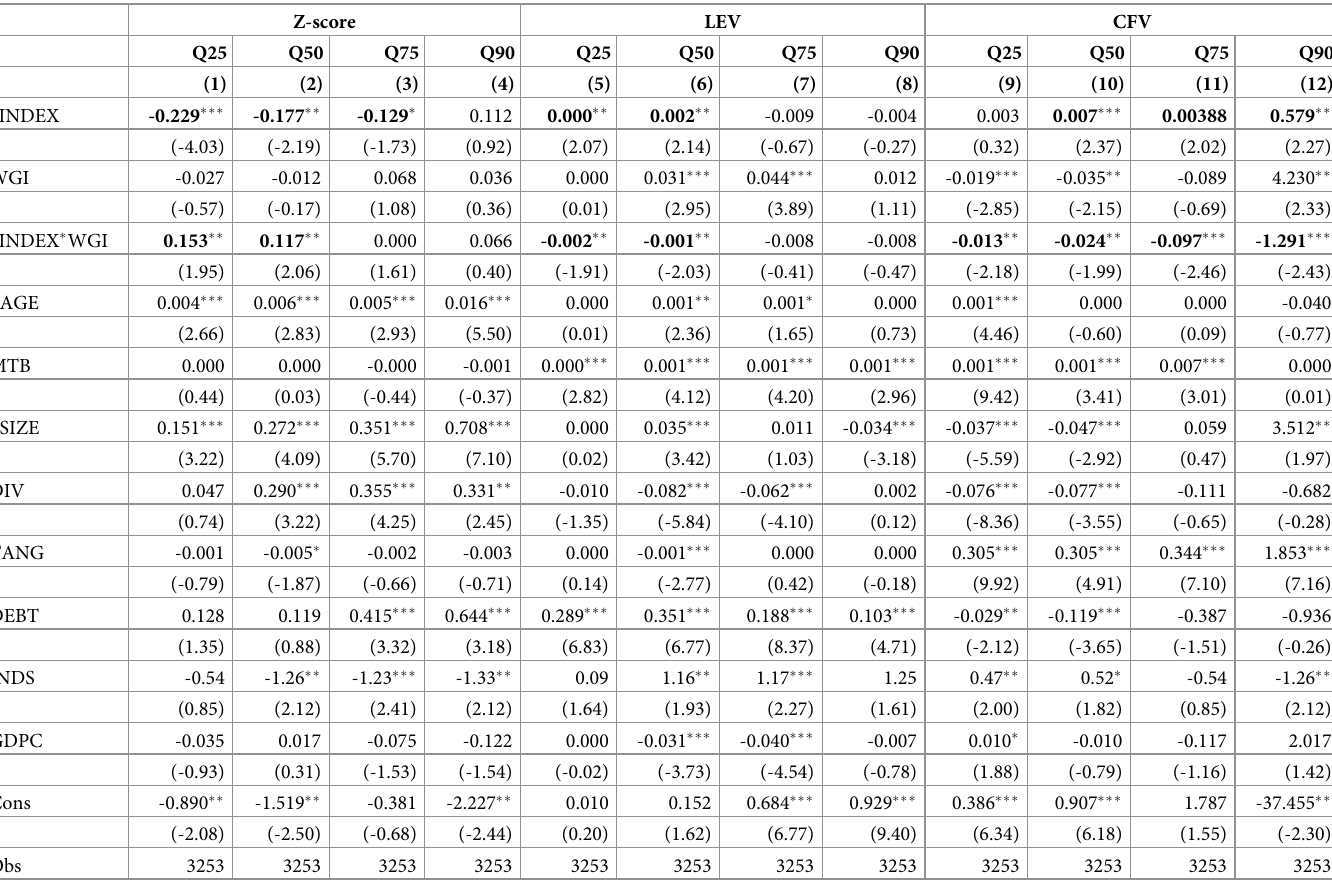
Table 11. Robustness test using quantile regression method for firm